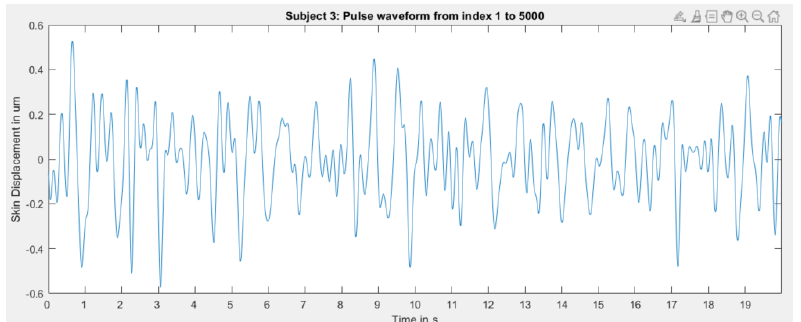
Figure 20. Extracted pulse waves for subject 3.